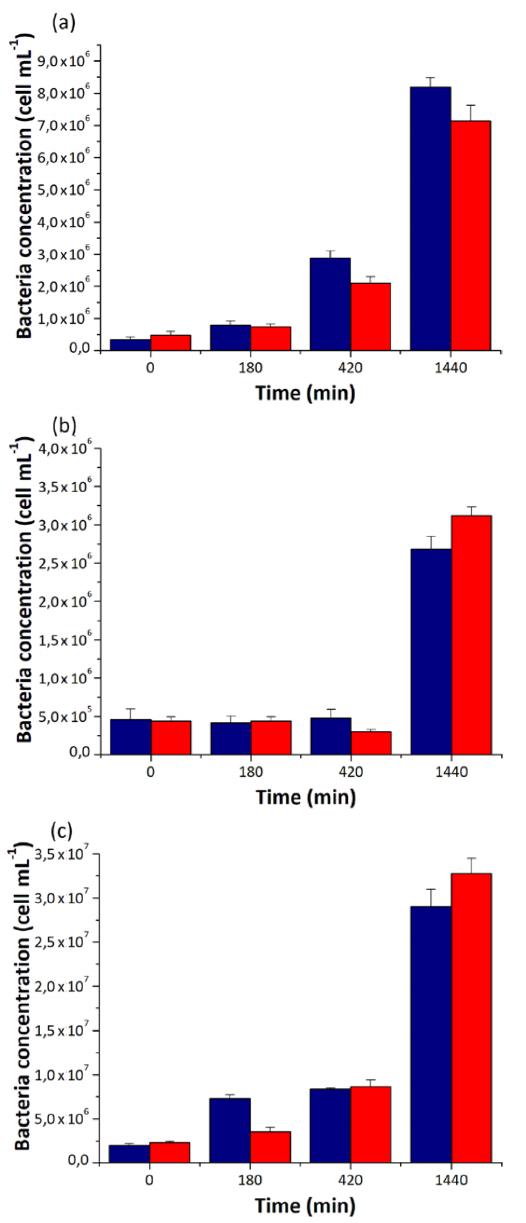
Figure 3. Bacterial cell numbers measured by plate-counting in the presence (red) and absence (navy) of H 2 O 2 at 20µM for the three strains: (a) Pseudomonas graminis (13b-3), (b) Pseudomonas sy- ringae (13b-2), and (c) Sphingomonas sp. (14b5). Error bars repre- sent the standard deviation from the means ( n = 3).